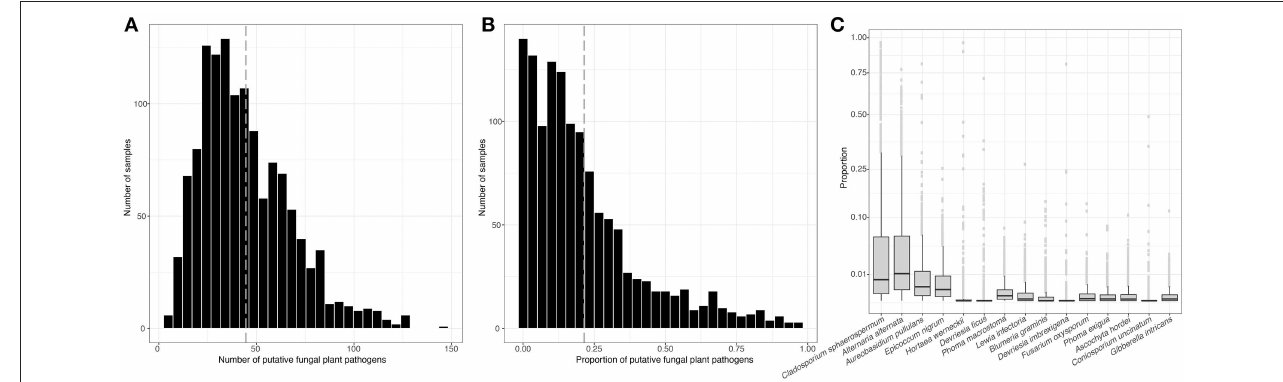
FIGURE 1 | Number of different putative fungal plant pathogens (richness) in individual dust samples (mean = 45) (A) . Abundance of putative fungal plant pathogens in dust samples (mean = 0.215) (B) . Means represented as vertical lines for (A,B) . Relative abundance of the most abundant species of fungal plant pathogens in dust samples (C) . Note that the y-axis in (C) is square root scale.